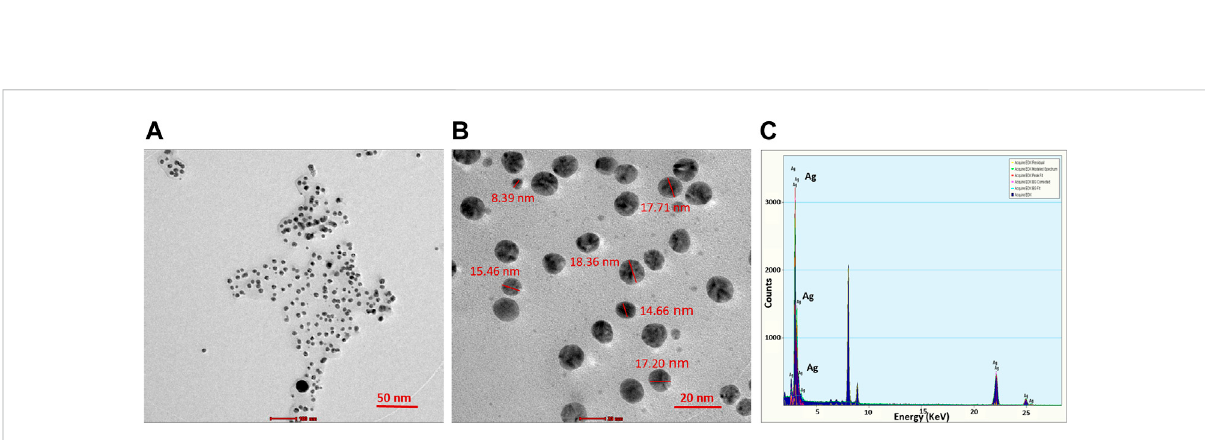
MBICs of the aqueous rhizome extract of CA against all four isolates were 3 mg/ml, > 3 mg/ml and 3 mg/ml respectively. MBICs of CAAgNPs against all four isolates was the same as their MICs against planktonic cells. Bio fi lm inhibition was observed in a dose- dependent manner for all the isolates tested (Figures 5A,B). Different letters on the bars indicate that mean values of the treatments are signi fi cantly different at p < 0.01 according to Tukey ’ s post hoc test. Error bars indicates the standard deviation from the three biological replicates.